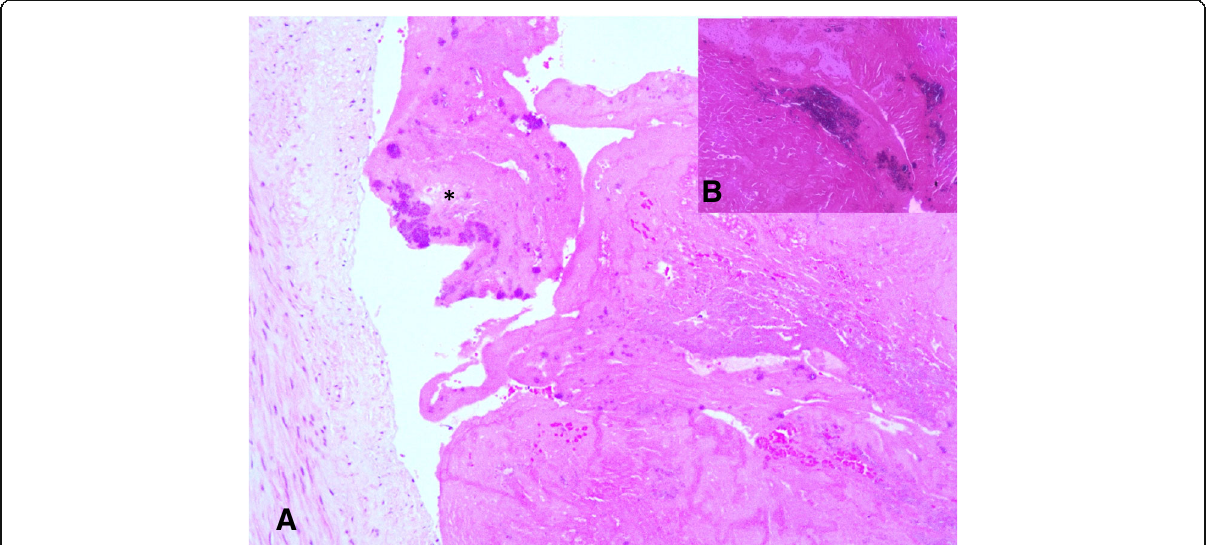
Fig. 2 Histology of the left main coronary artery ( a ), showing luminal occlusion by septic thrombus with the presence of bacterial colonies (asterisk). The inset ( b ) demonstrates Gram-positive cocci in the thrombus. Magnification a , (H&E × 100); inset b (Gram stain × 200)